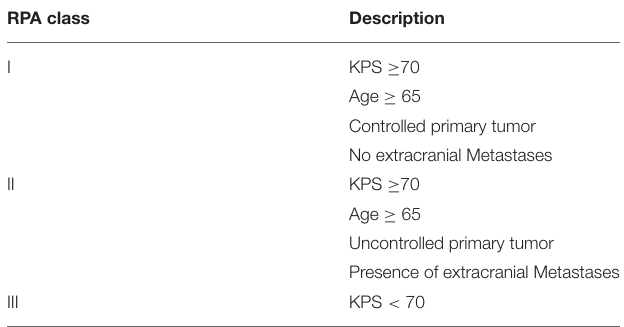
TABLE 2 | Recursive Partitioning Analysis scoring system for patients with spinal metastases.